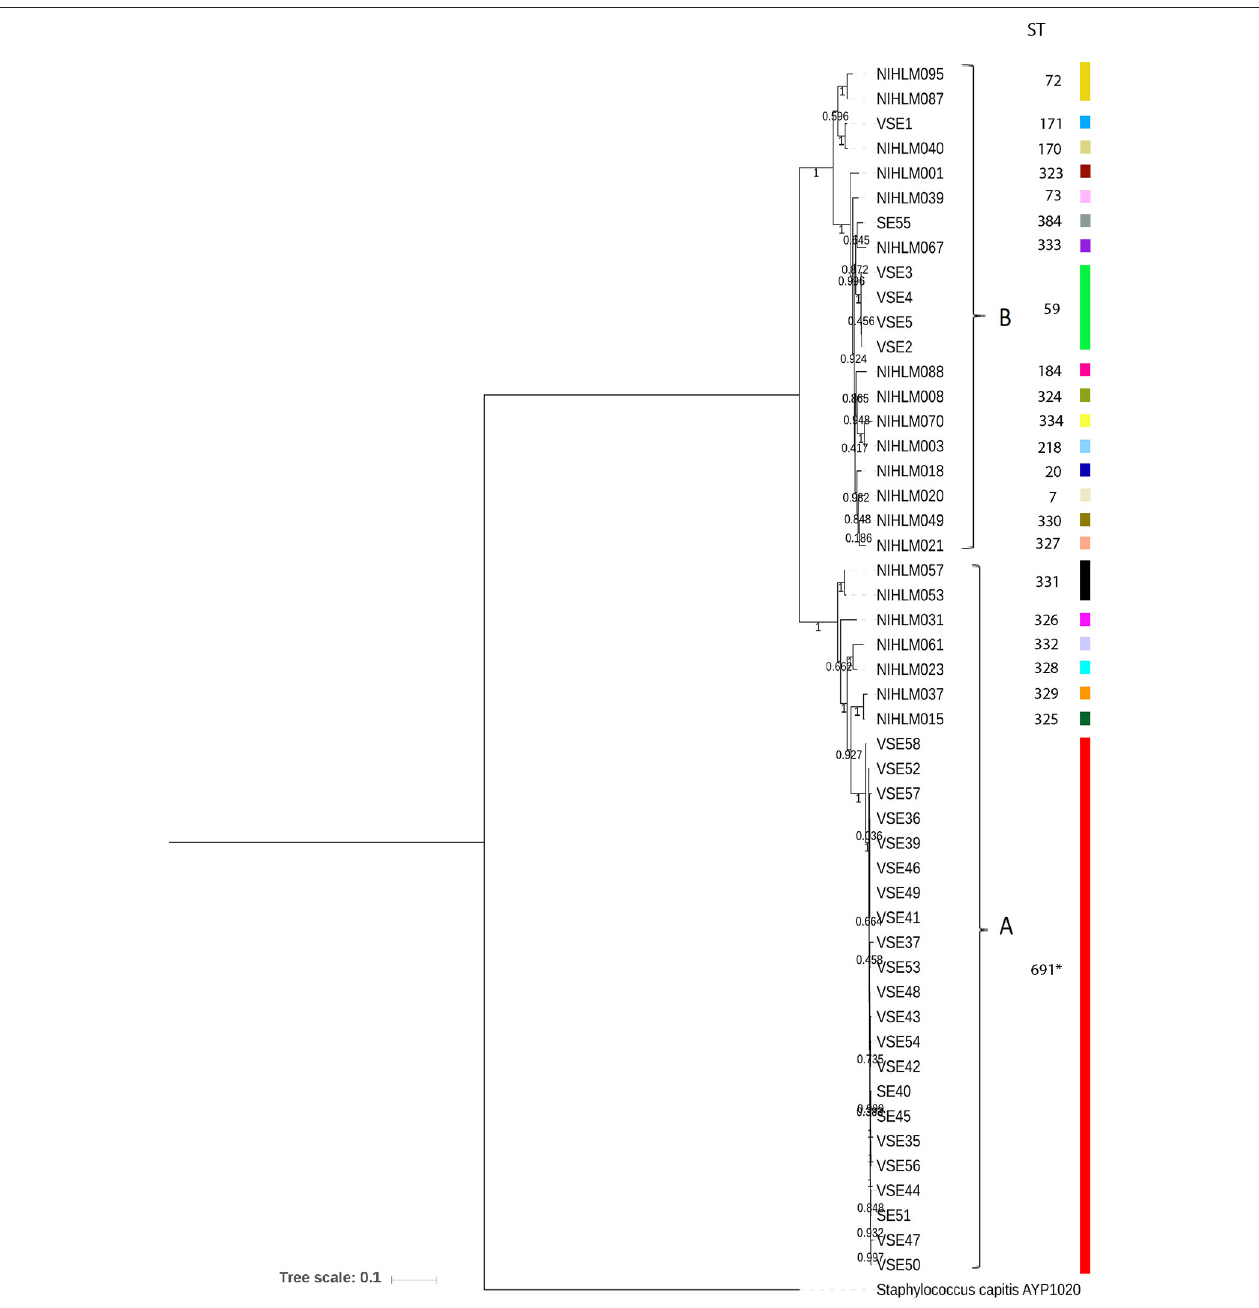
FIGURE 1 | Phylogenetic tree among 49 Staphylococcus epidermidis isolates, based on protein sequence of 400 universal housekeeping genes, using MEGA7.10.18. S. capitis AYP1020 was used as outgroup of the tree and bootstrap values are highlighted on the branches. STs of all isolates are mentioned against them and isolates with similar STs or clones are represented with same